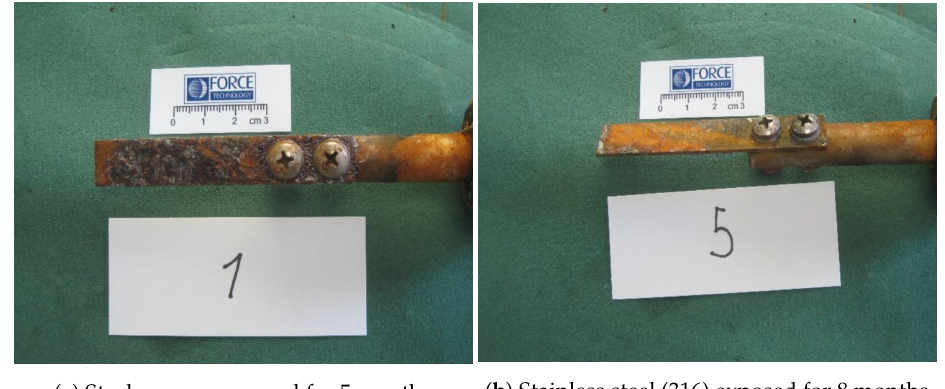
Figure 7. Results of on-line corrosion measurements in the Sønderborg loop after injection pump Force Technology. Edited from Mathiesen et al.